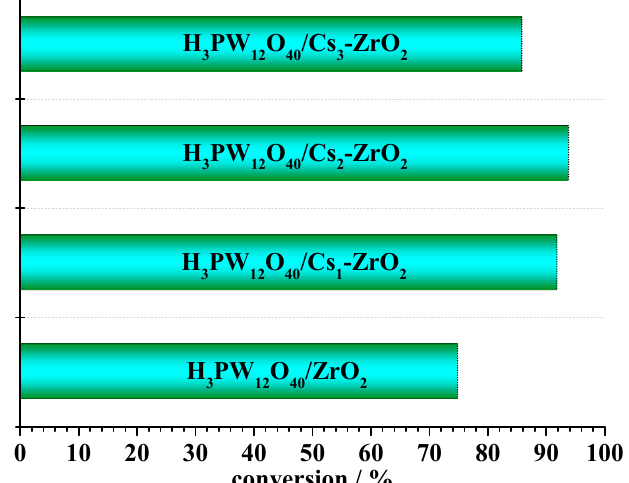
Figure 6. Esterification of glycerol with HOAc over phosphotungstic acid supported on Cs − containing ZrO 2 (H 3 PW 12 O 40 /Cs ZrO 2 ) (adapted from ref. [49]).